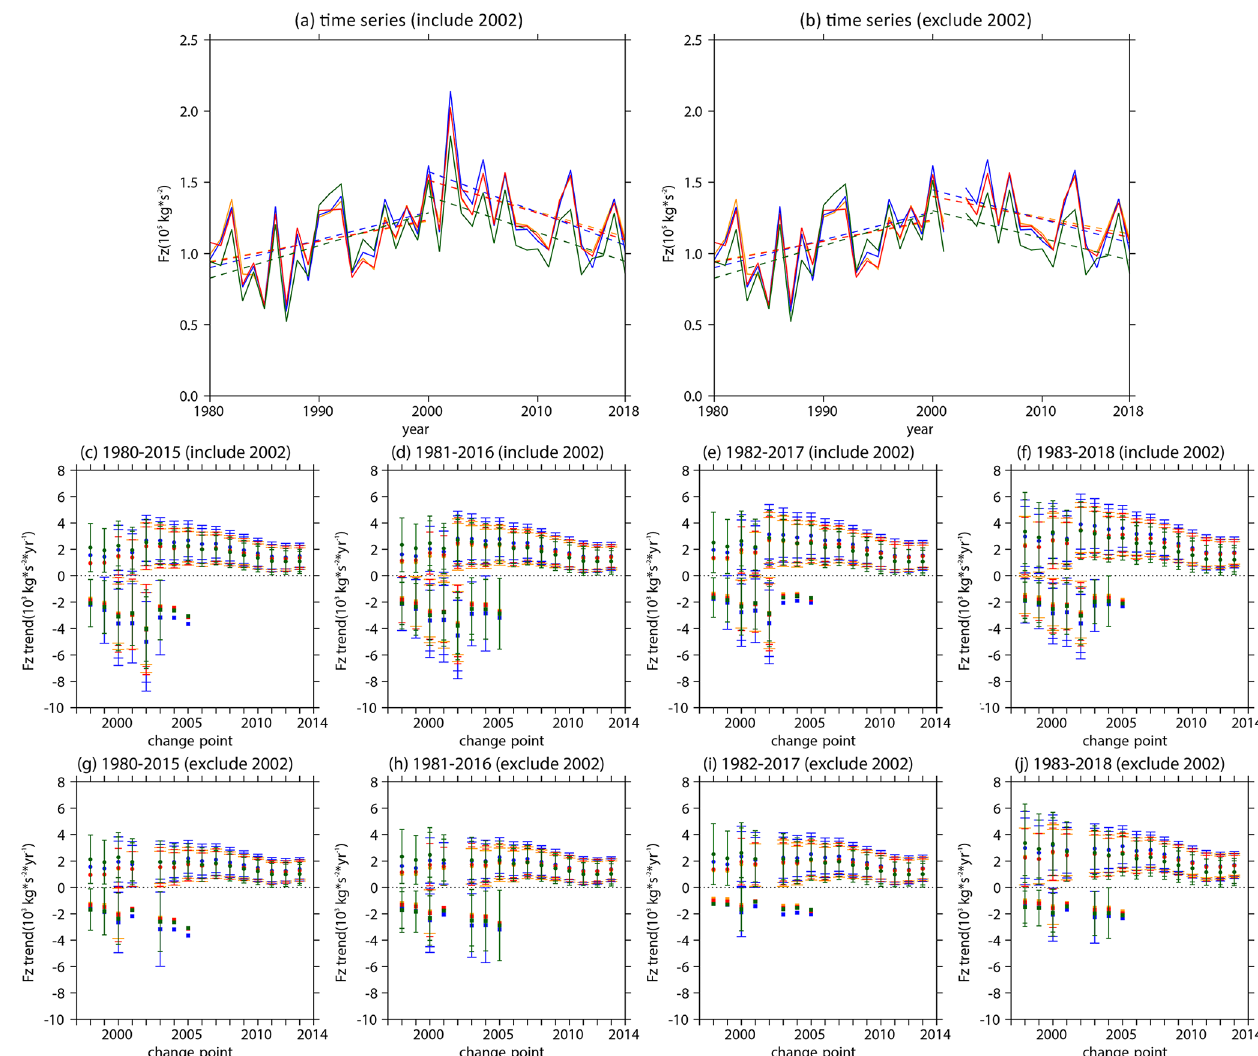
Figure 2. (a) The mean time series (solid lines) and piecewise (during 1980–2000 and 2000–2018) linear regressions (dashed lines) of vertical E–P flux area weighted from 100 to 30hPa over 70–50 ◦ S in September during 1980–2018 as derived from ERA-Interim (yellow), MERRA-2 (blue), JRA-55 (red), and NCEP-2 (green). Panel (b) is the same as panel (a) , except that the data in 2002 are removed. (c, d, e, f) The trends (dots) and uncertainties (error bars) calculated during various periods using the change point method with different beginning and ending years (titles). Circles and squares in panels (c) , (d) , (e) , and (f) represent positive trends from the beginning years to change point years ( x axes) and negative trends from change point years to ending years, respectively. Different colors of the dots and error bars in panels (c) , (d) , (e) , and (f) correspond to colors in panel (a) , which represent trends and uncertainties derived from different datasets. The long and short error bars in same color reflect the 95% and 90% confidence intervals calculated by two-tailed t test. The error bar is omitted when the significance of the trend is lower than the corresponding confidence level. Negative trends and corresponding uncertainties with the beginning change point in the years after 2005 are also omitted, since the trend value shows a large fluctuation with the shortening of the time series. Panels (g) , (h) , (i) , and (j) are the same as panels (c) , (d) , (e) , and (f) , except that the data in 2002 are removed when calculating trends and